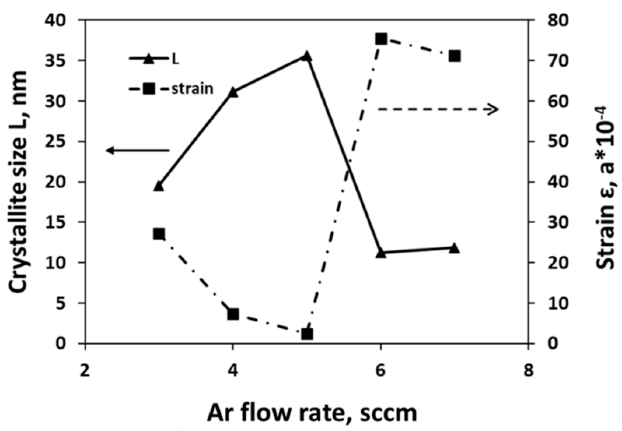
Figure 6. Relation between crystallite size (L) and strain for different gas flow rates of as-deposited WS 2 films.